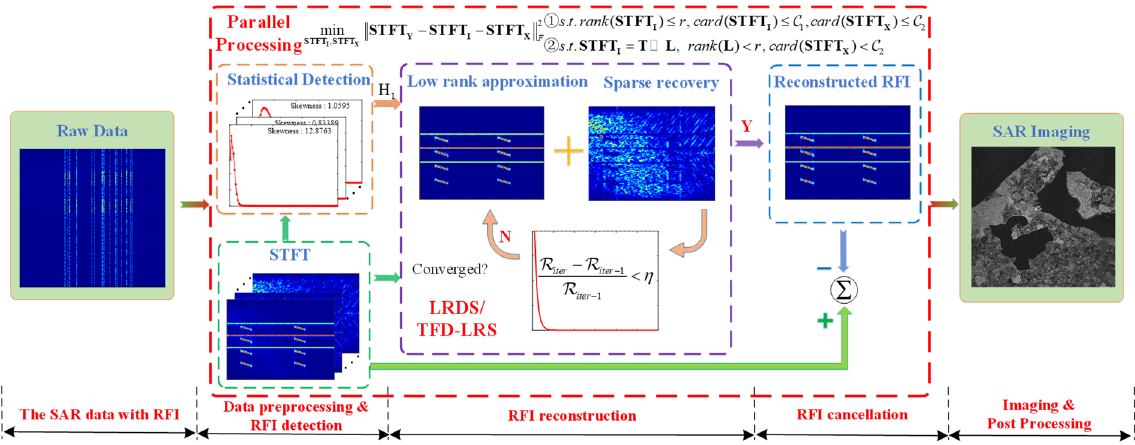
Figure 2. Flowchart of the proposed algorithms incorporating the SAR imaging process. ① and ②